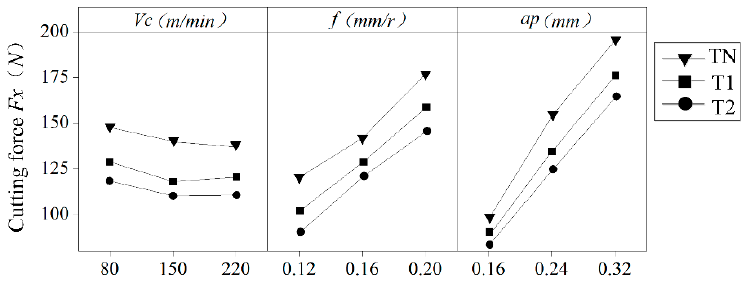
Figure 11. Single factor effect of cutting parameters on cutting force.